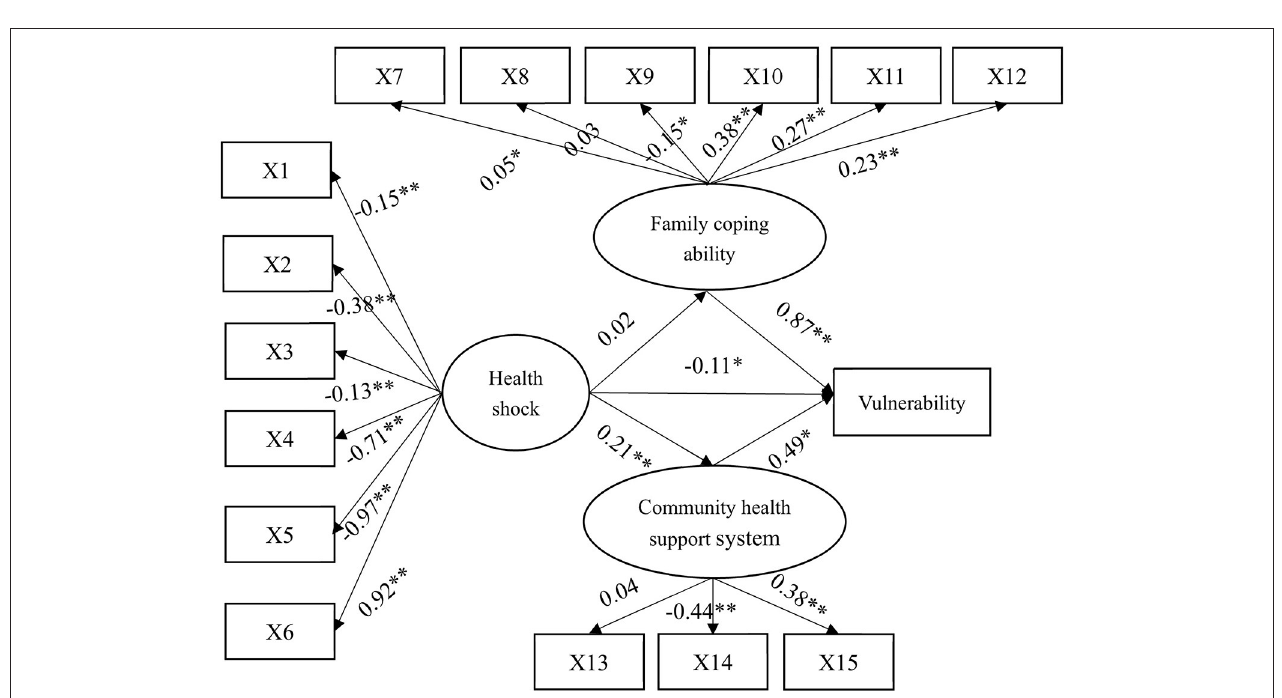
FIGURE 2 | Full-sample structural equation model path diagram and standardized solution. * p < 0.05 ** p < 0.01.